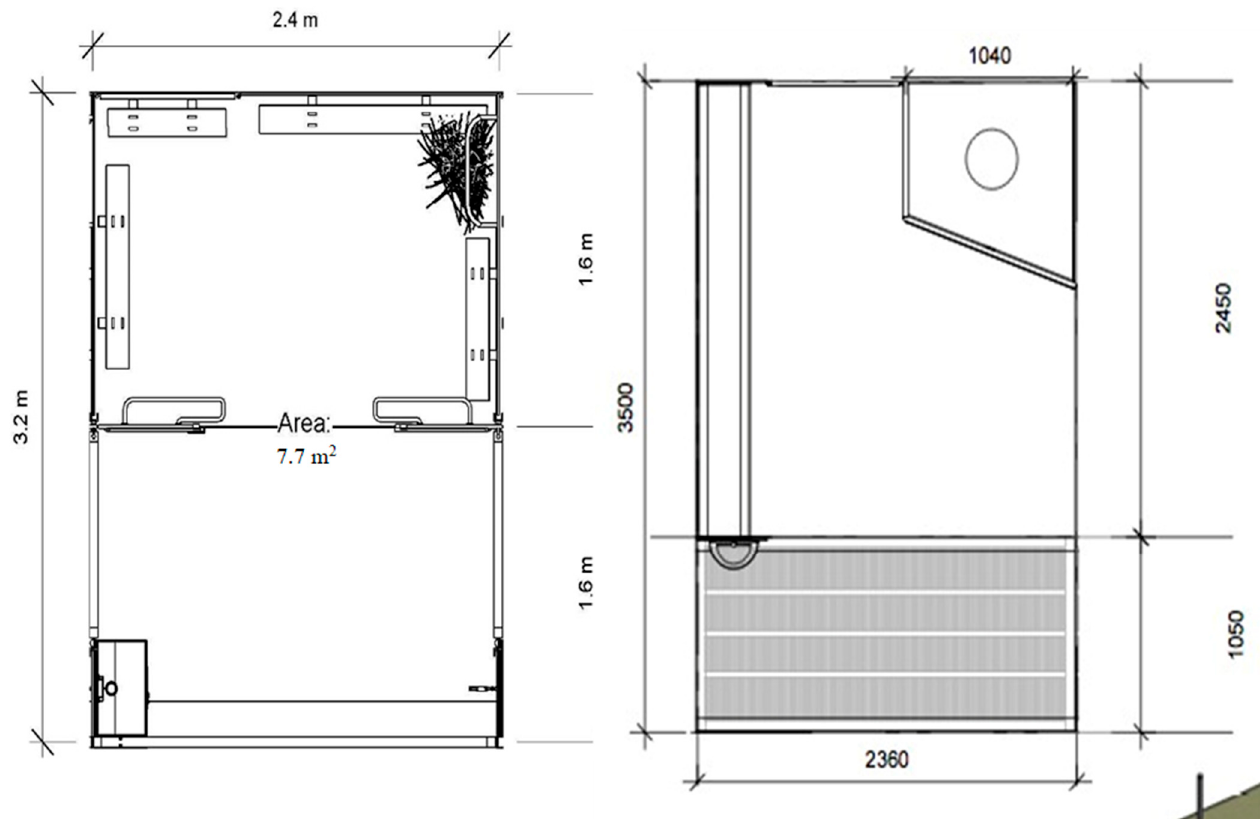
Figure 4. Overview of both SOWCOMF ( left ; measures given in metres) and TRAD ( right ; measures given in centimetres) with specific measurements.